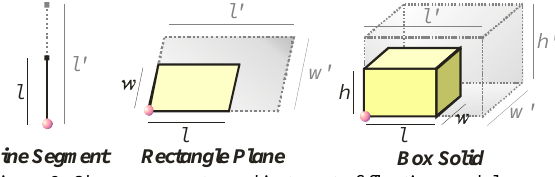
Figure 3: Shape parameters adjustment of floating models When the pictures are taken, buildings are projected on the picture based on the central projection. The object point, exposing centre, and the image point should lie on the same straight line, which is the essential of the collinearity equations.